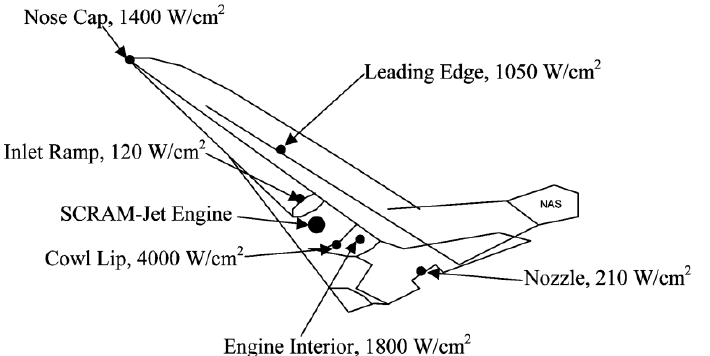
Figure 1. Thermal environment for a hypersonic vehicle. Reprinted/adapted with permission from Ref. [8]. 2005, American Institute of Aeronautics and Astronautics Inc.